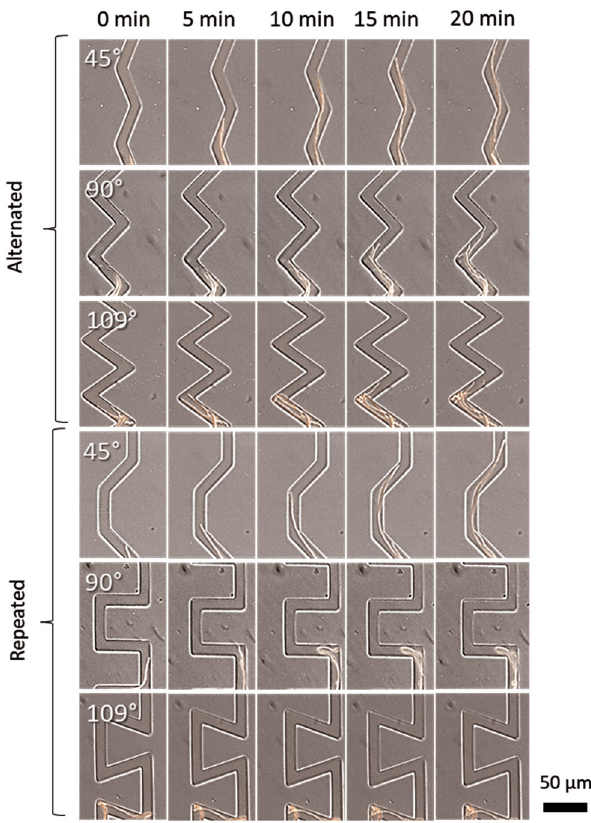
Fig. 3 Time lapse images of C. cinerea passing through the different types of channels in the absence of a competitor at day 1. Pictures were taken with a 40X objective at a time interval of 5 min in bright fi eld with DIC overlayed with the red fl uorescence